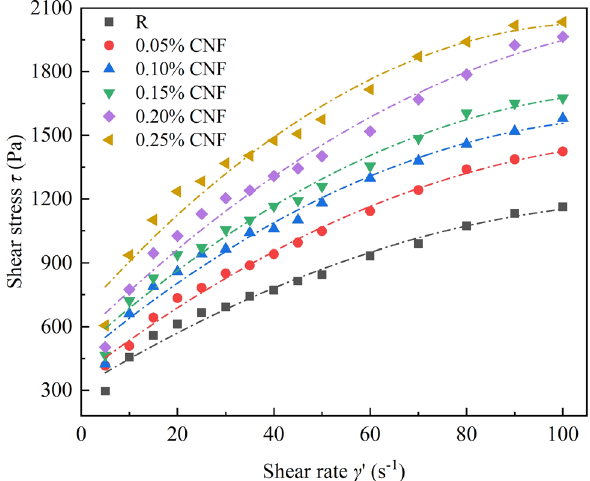
Figure 3: Rheological curves of the UHPC matrix with various concentrations of CNF suspensions.